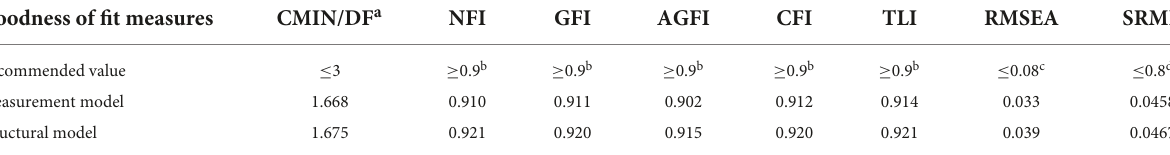
TABLE 4 Analysis of measurement and structural model. Goodness of fit measures